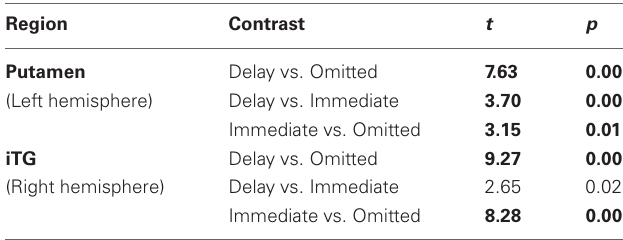
Table 2 | ROI analysis of brain areas with stronger BOLD signal after delayed compared to omitted feedback.